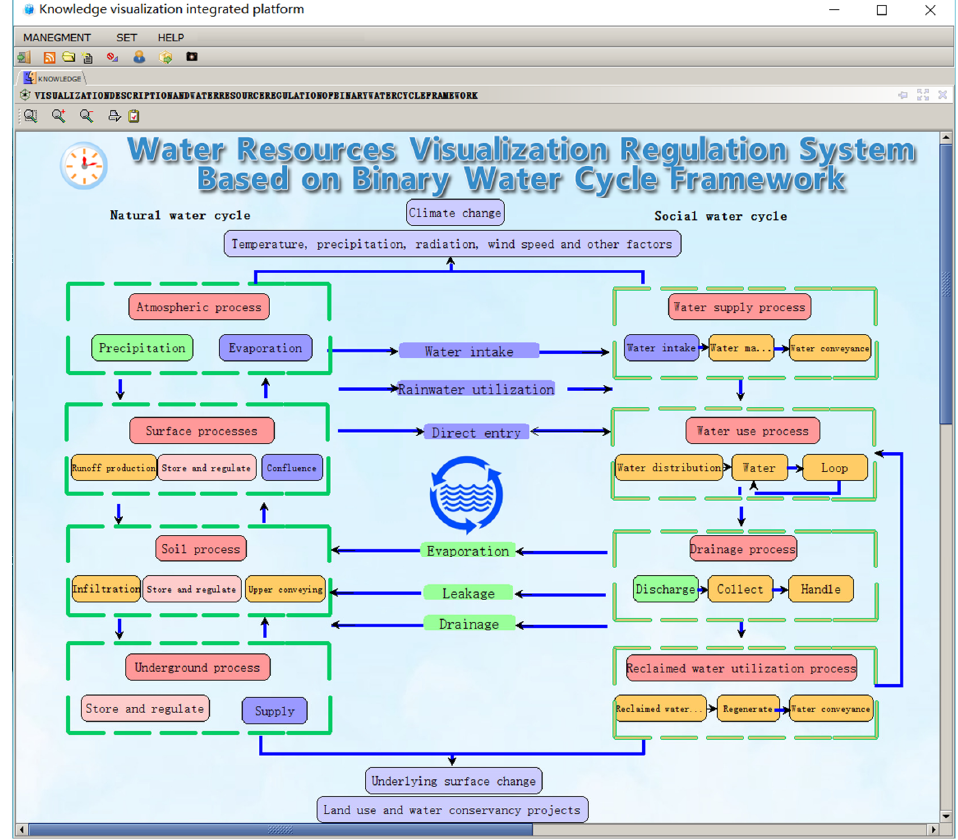
Figure 6. Main visualization interface of the dualistic water cycle